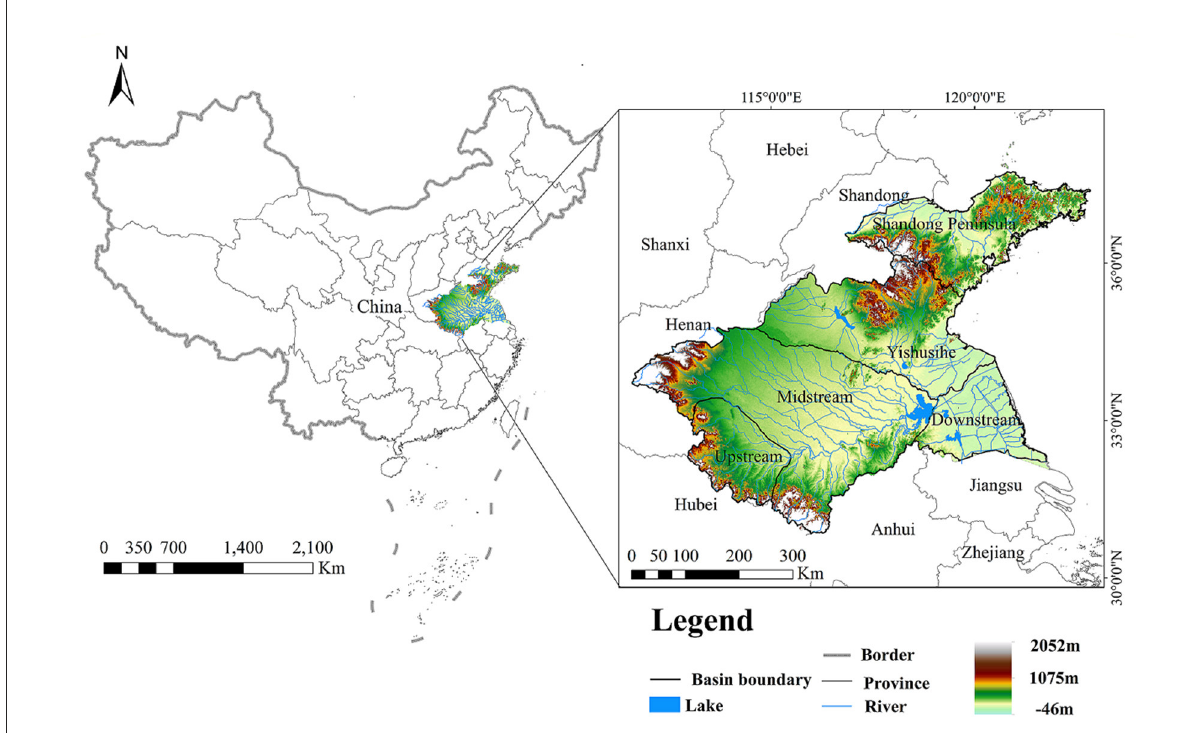
FIGURE2 Geographic location of the Huaihe River